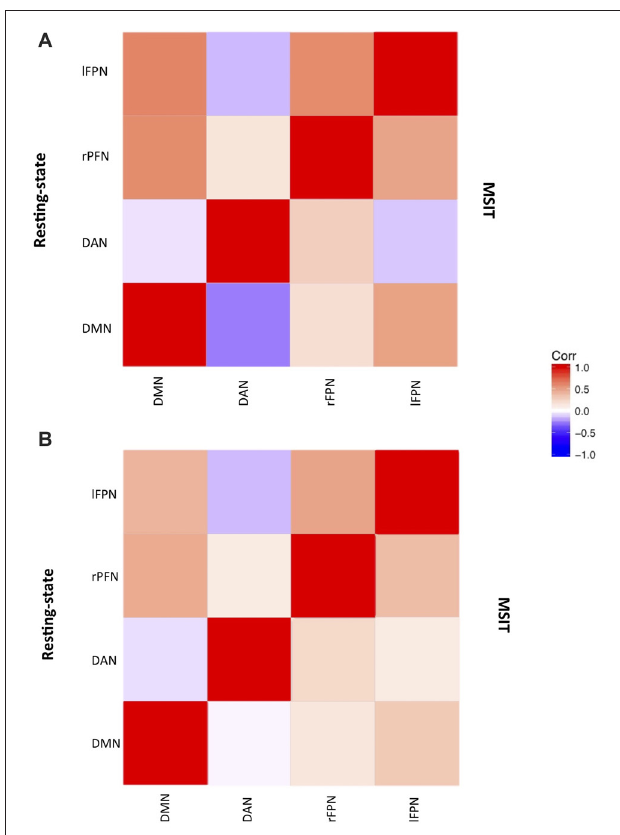
FIGURE 2 | Networks correlation matrix during resting-state (upper-case diagonal) and interference resolution (lower-case diagonal) for (A) young and (B)